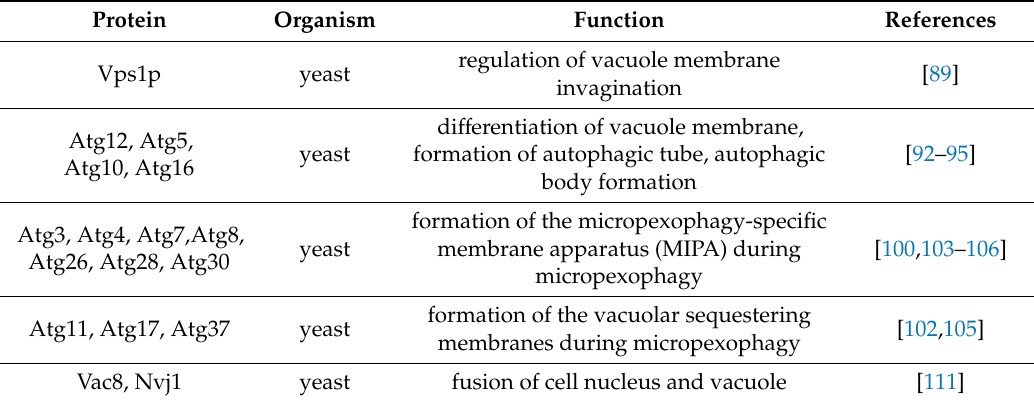
Table 2. Proteins involved in the formation of the autophagic body during microautophagy.